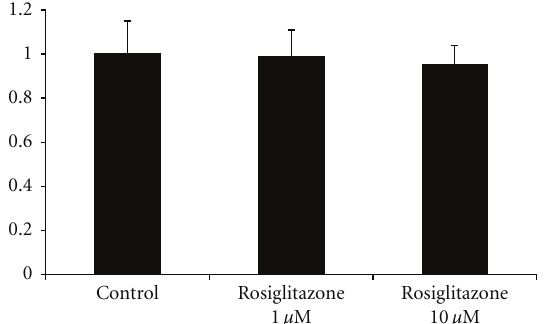
Figure 3: E ff ect of rosiglitazone on mesothelial cell viability and proliferation. MC were stimulated with rosiglitazone in the given concentrations for 48 hours, and then a MTT test was performed as described in the Methods section. Results are described in relation to the